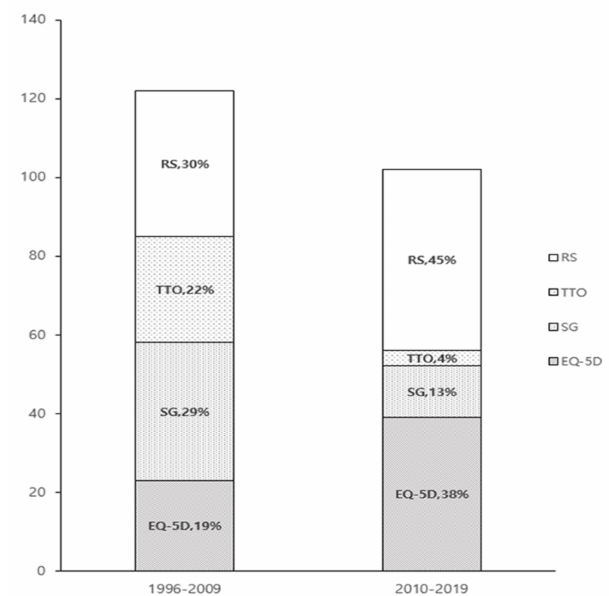
Figure A1. Percentage of assessment methods used in the studies from January 1996 to April 2019 (total n = 224). Year 1996~2009, n = 122; year 2010~2019, n = 102; SG = standard gamble; RS = rating scale; TTO = time-tradeo ff ; EQ-5D = Euroqual-5